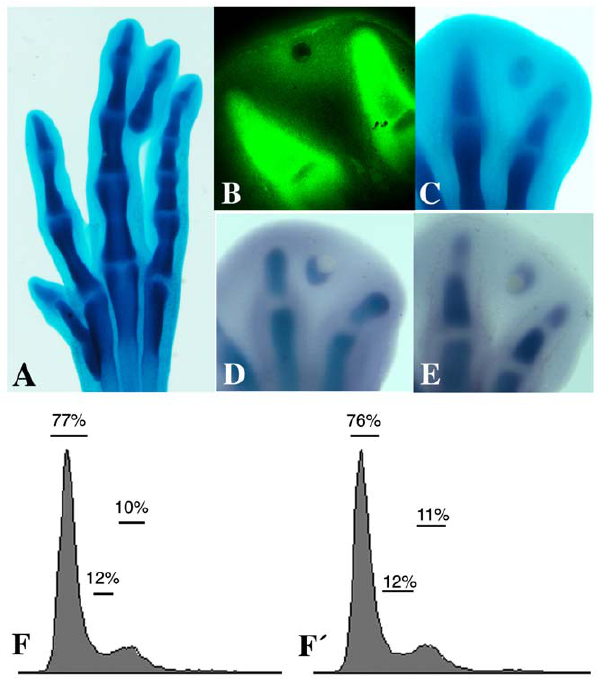
Figure 1. Characterization of chondrogenesis induced by interdigital application of a heparin bead incubated in 2 m g/ ml Tgf b 1. A, Morphological appearance of the extra digit 3 days after the interdigital implantation of a Tgf b bead. B, PNA positive labeling of the interdigital mesoderm 10 hr after the implantation of a Tgf b bead. C, Alcian blue-positive cartilage 22 hr after the implantation of a Tgf b bead. D, presence of an ectopic aggrecan gene expression domain 12 hr after the implantation of a Tgf b bead. E, Presence of an ectopic collagen 2 alpha 1 expression domain 17 hr after the implantation of a Tgf b bead. (*) Tgf b bead; (D3) digit 3; (D4) digit4. F-F 9 charts representing cell proliferation of control interdigits (F) and of those treated with a Tgf- b bead (F 9 ) as measured by flow cytometry. The percentages of cells in the G0/G1, S, and G2/M phases of the cell cycle are shown.